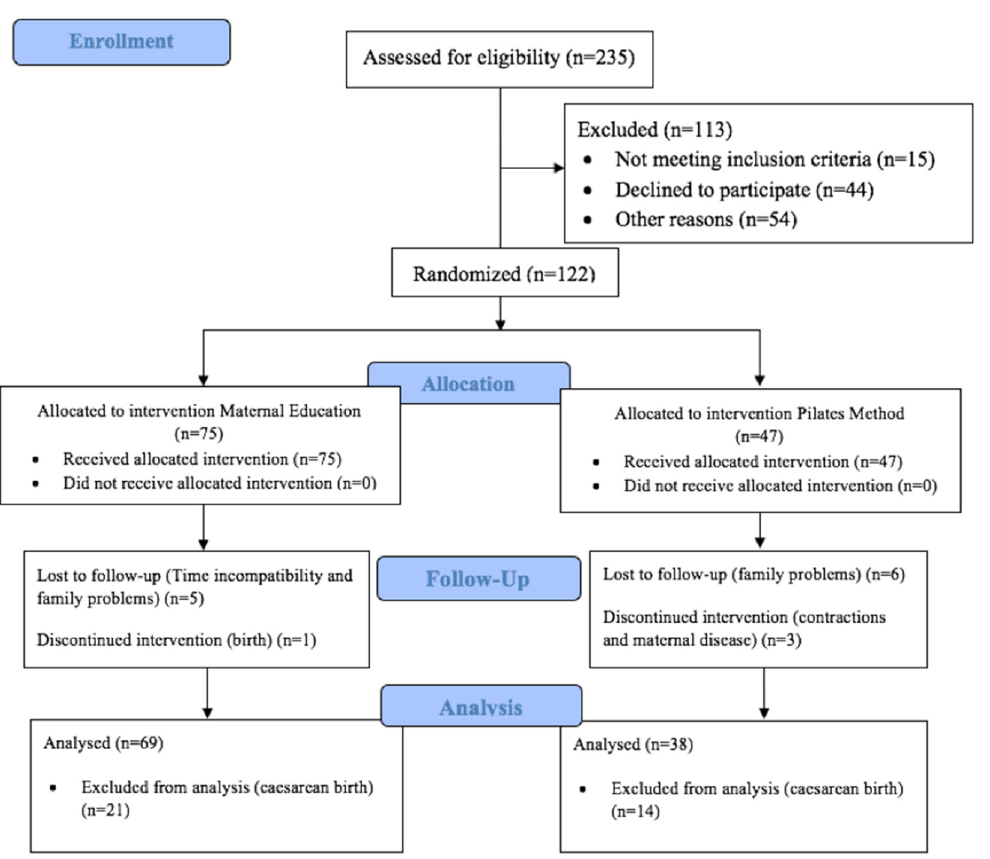
Figure 1. The flow diagram of the participants through each stage of the study.